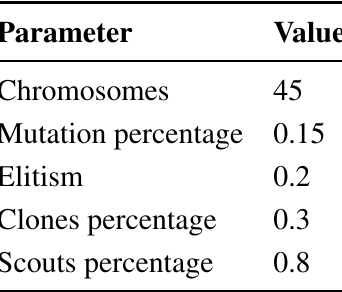
Table 4. Parameters of GA.